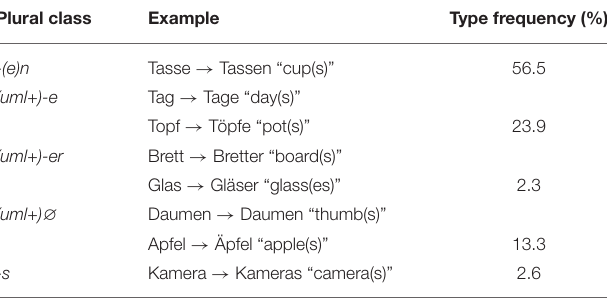
TABLE 1 | Plural classes of German nouns (relative frequencies from Gaeta, 2008 ).